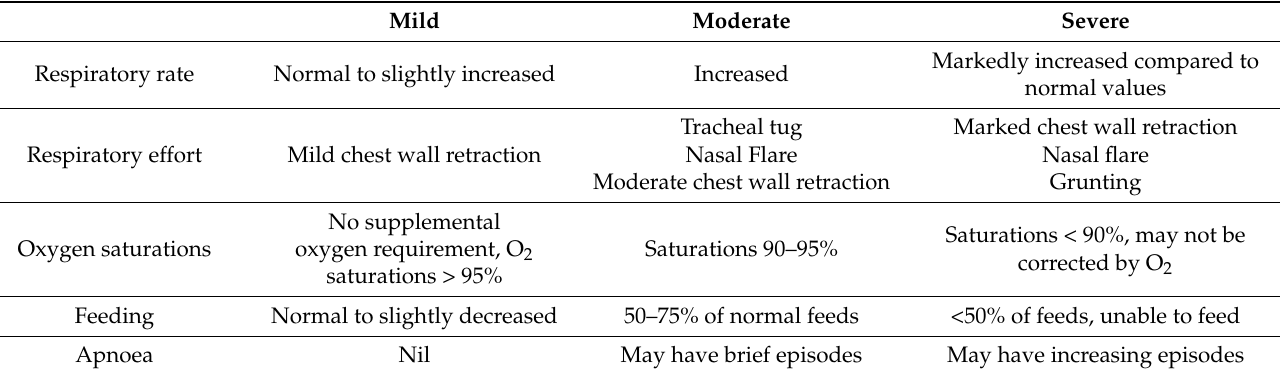
Table 1. Bronchiolitis severity score